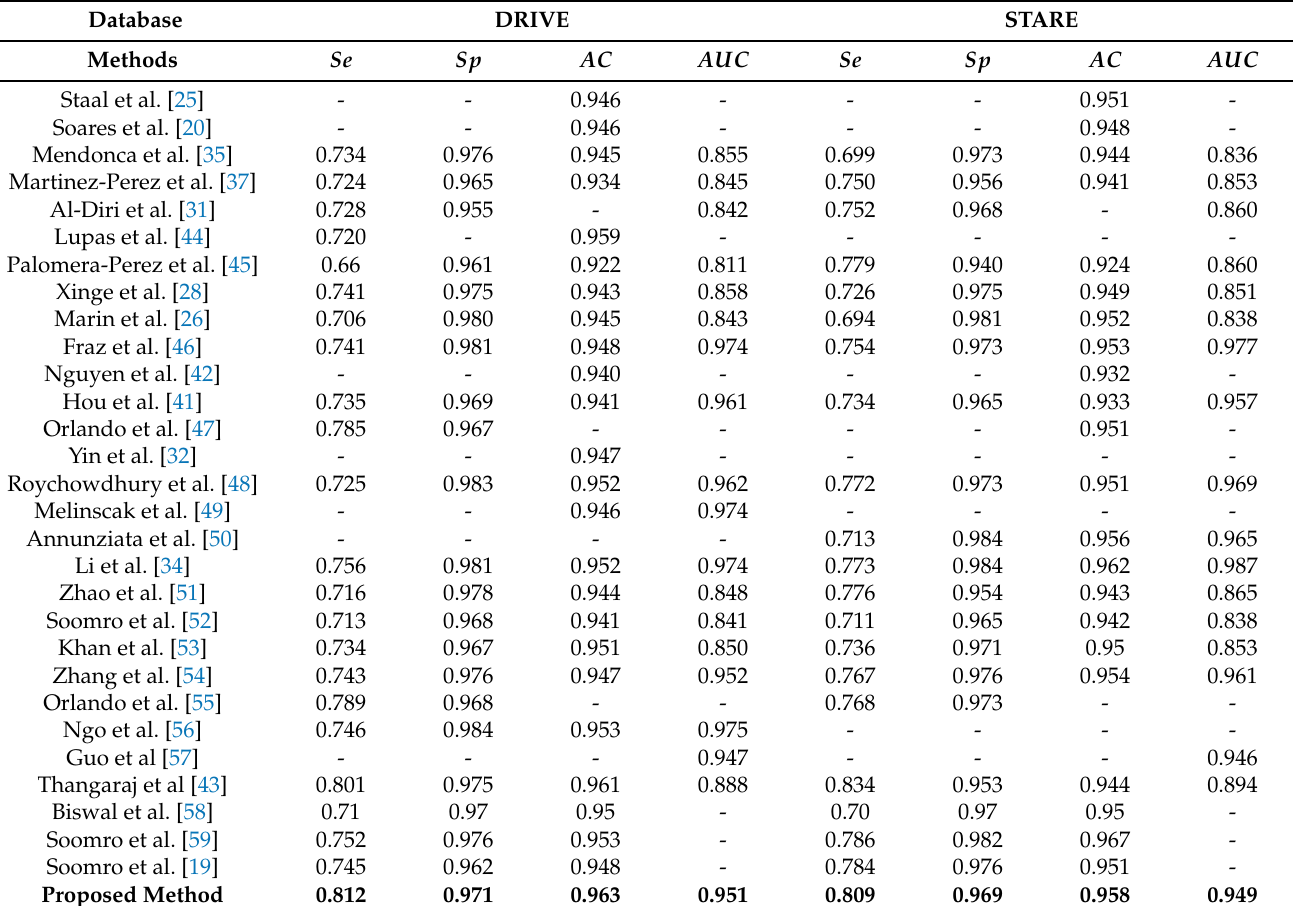
Table 6. Comparison of Proposed Method with Existing